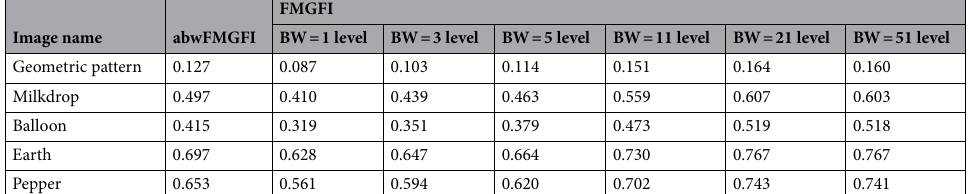
Table 10. Comparison of the SSIM values of each sample image filtered using the variable level of BW of FMGFI (against the Gaussian